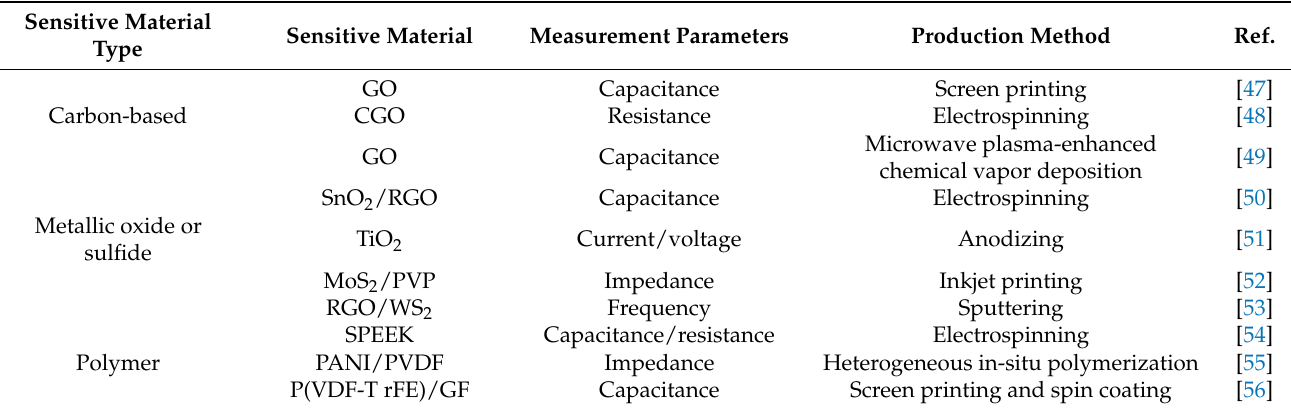
Table 1. Recent studies on humidity